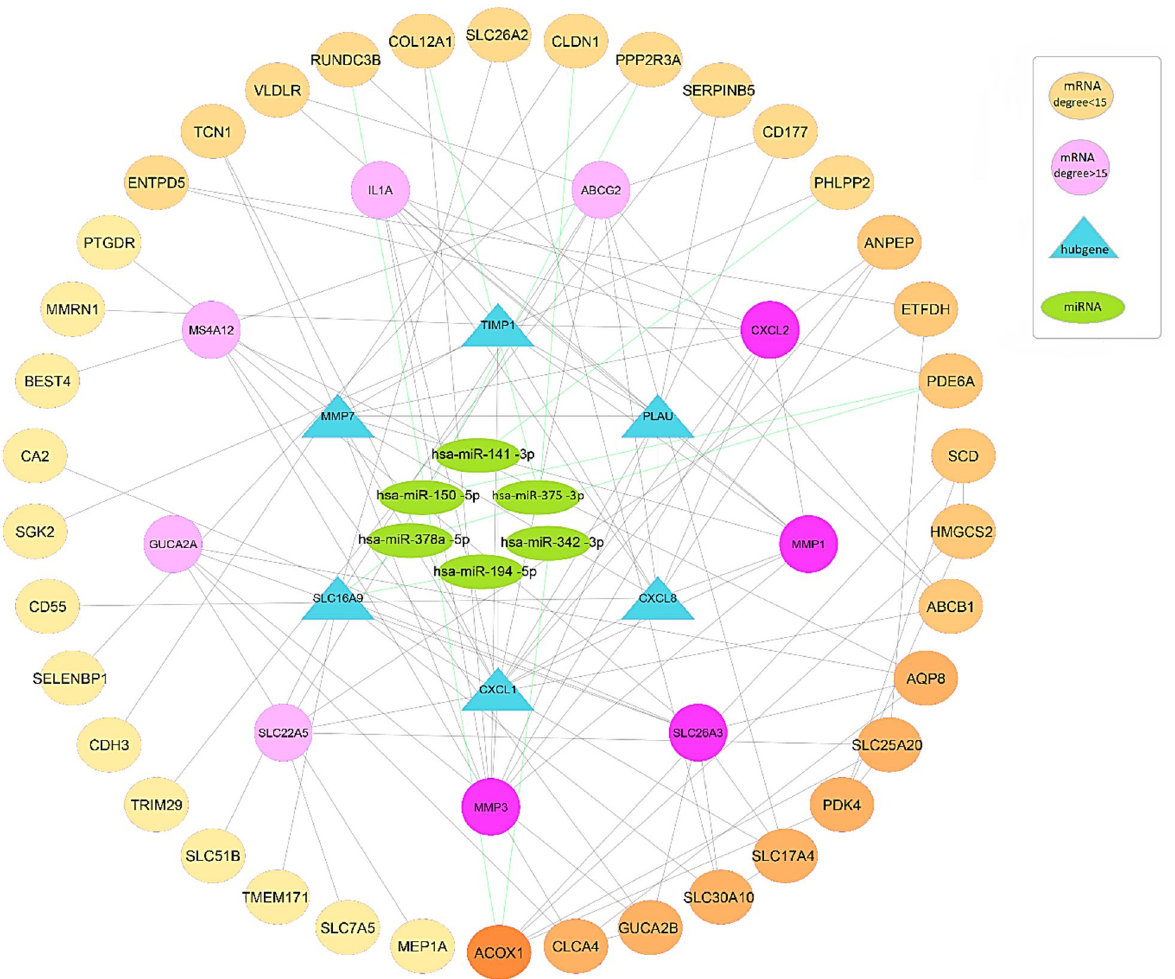
Figure 11. Visualization of miRNA-Gene-Network using gene expression data and interactions predicted by STRING and Cytoscape tools. Circles and triangles represent genes and ovals represent miRNAs. Key genes in the network always have the highest rank. The outer circles are the genes whose rank and degree are less important in the network analysis and related algorithms, whose importance and degree in terms of involvement in the pathogenesis pathways are shown in pale yellow to orange color degrees. Pink circles and blue triangles are 15 key genes in terms of Drgree, Betweenness, and Closeness, in other words, the center of the network indicates the degree. And the gradation of pink circles is shown as a color plot from light to dark pink. The blue triangles represent six important hub genes in terms of network analysis and MCODE and Cytohubba algorithms, according to the degree of importance. Green links indicate the target score between the miRNA and the target